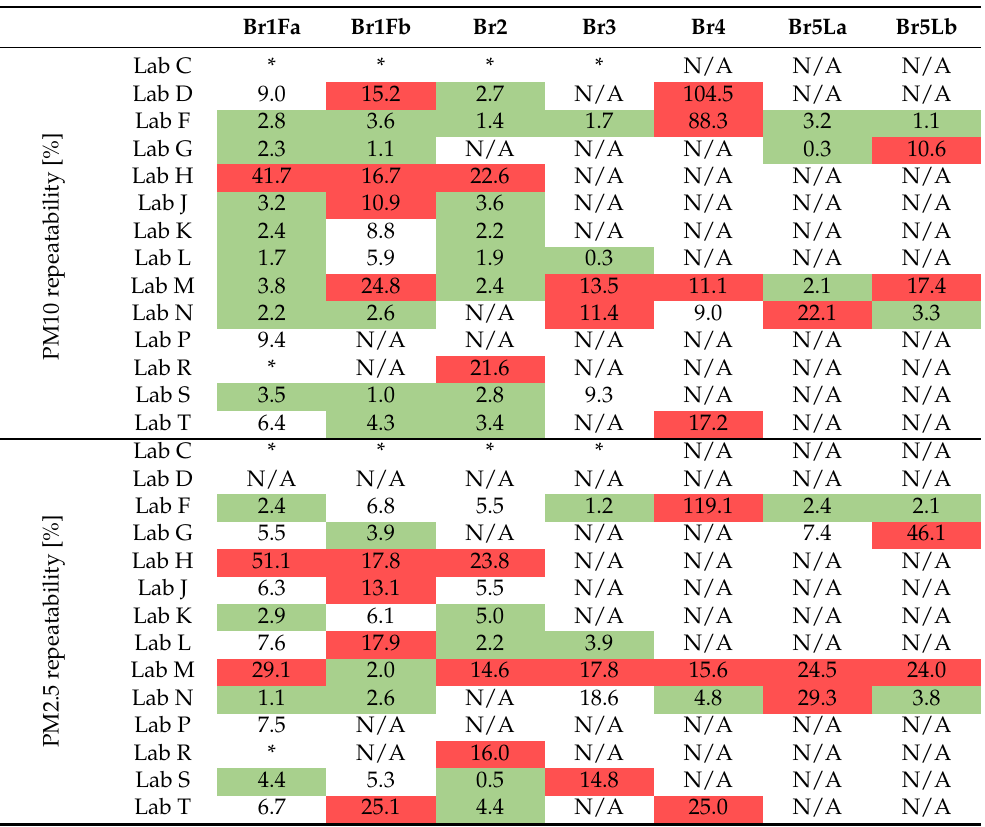
Table 6. PM10 and PM2.5 measurement repeatability. Green cells indicate very good repeatability (CoV ≤ 5%), while red cells indicate not good repeatability (CoV > 10%). Asterisks denote testing facilities that accumulated the mass from the three PM emission measurements on one filter. N/A denotes brakes not tested by the testing facility or a parameter not measured by the testing facility for a given